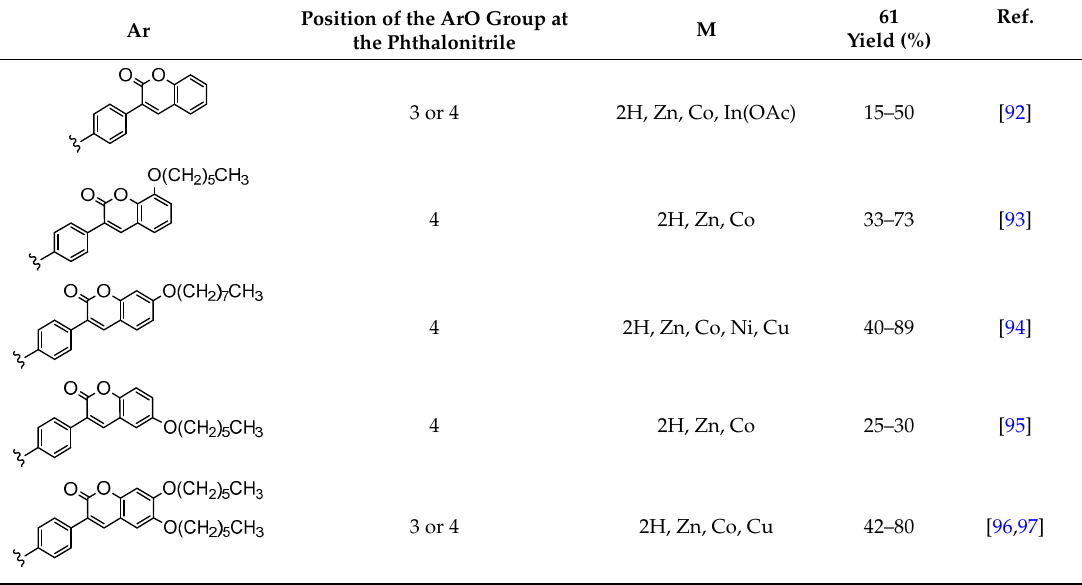
Table 2. Coumarin–phthalocyanine conjugates 62 and yields.